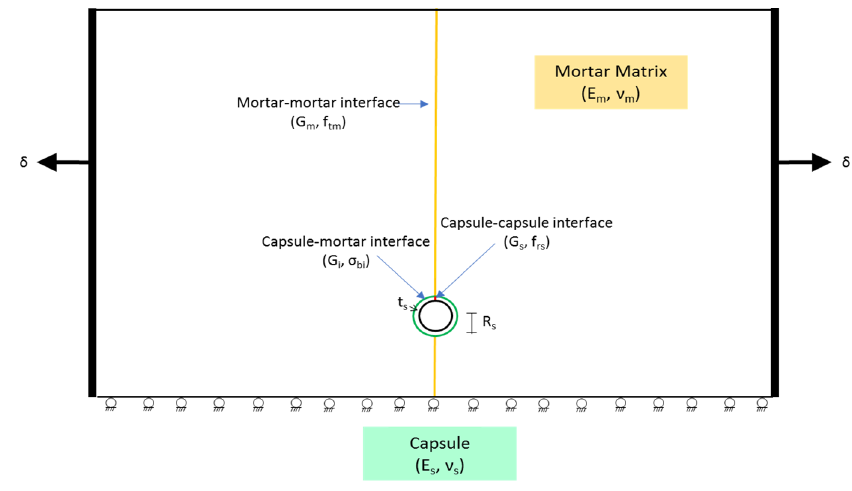
Figure 1. FE model schematic view including geometry, boundary conditions, and loading conditions.